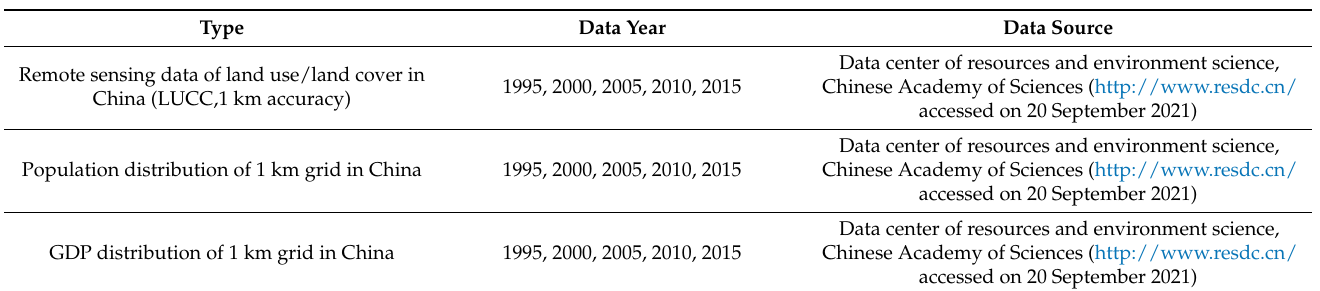
Table 1. Data sources.